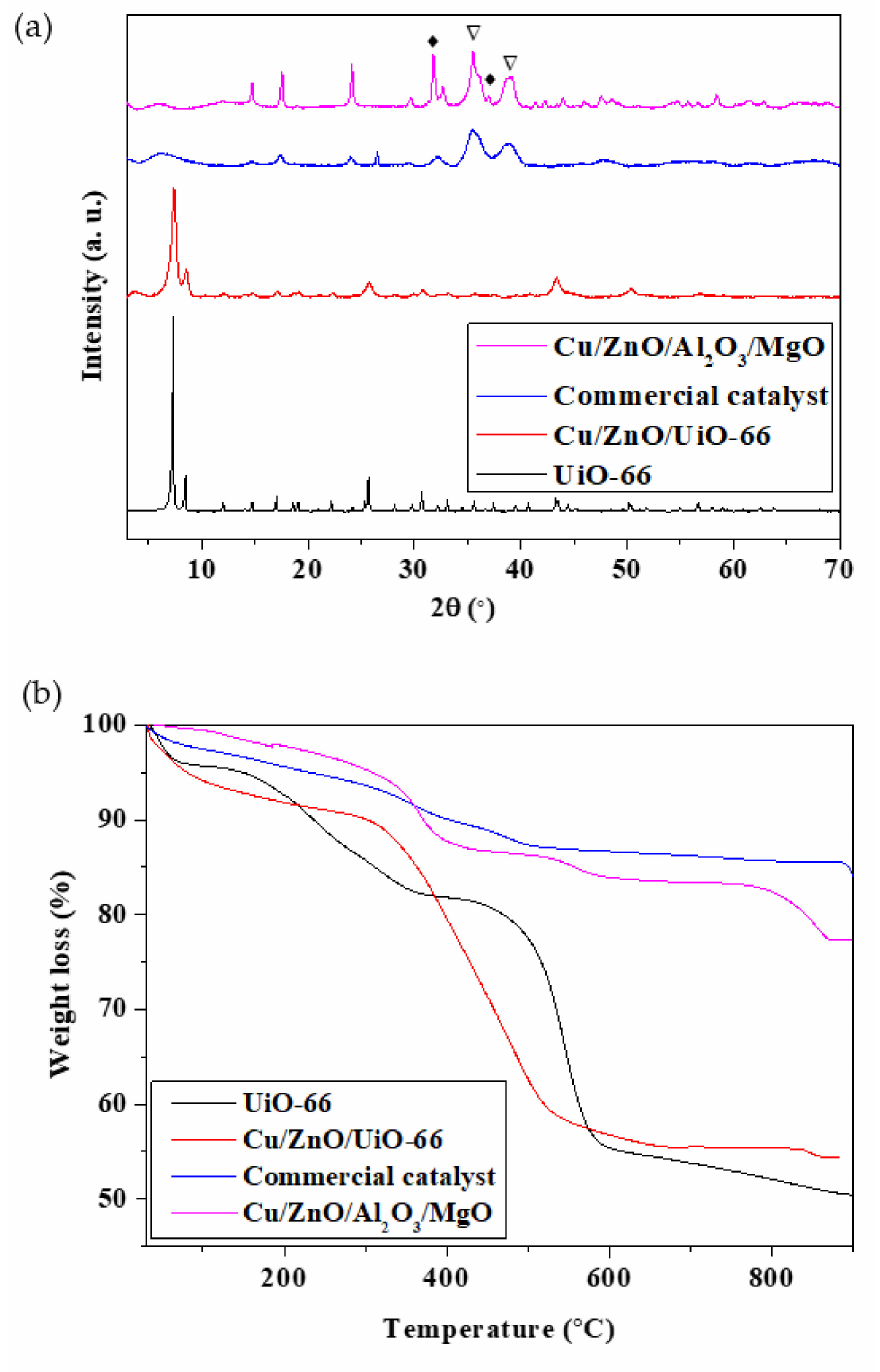
Figure 1. ( a ) XRD patterns and ( b ) TGA profiles of commercial catalyst, Cu/ZnO/Al 2 O 3 /MgO catalyst, UiO-66, and Cu/ZnO/UiO-66. (cid:7) ZnO, (cid:72)